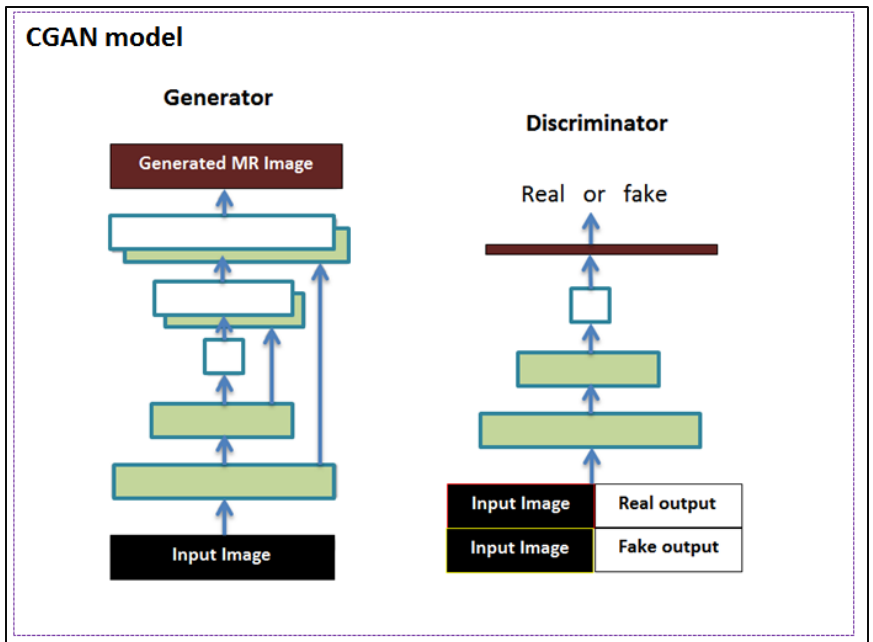
Figure 3. The CGAN model architecture. The generator employs the U-Net architecture, whereas the discriminator is a convolutional network.